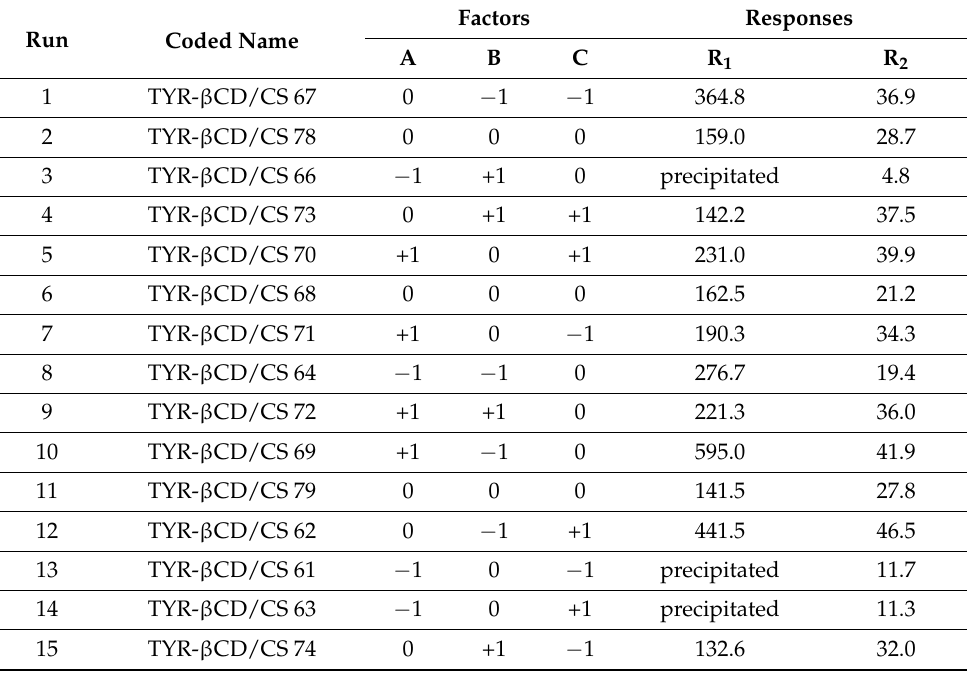
Table 4. Experimental data of TYR- β CD/CS nanosystem and obtained results.